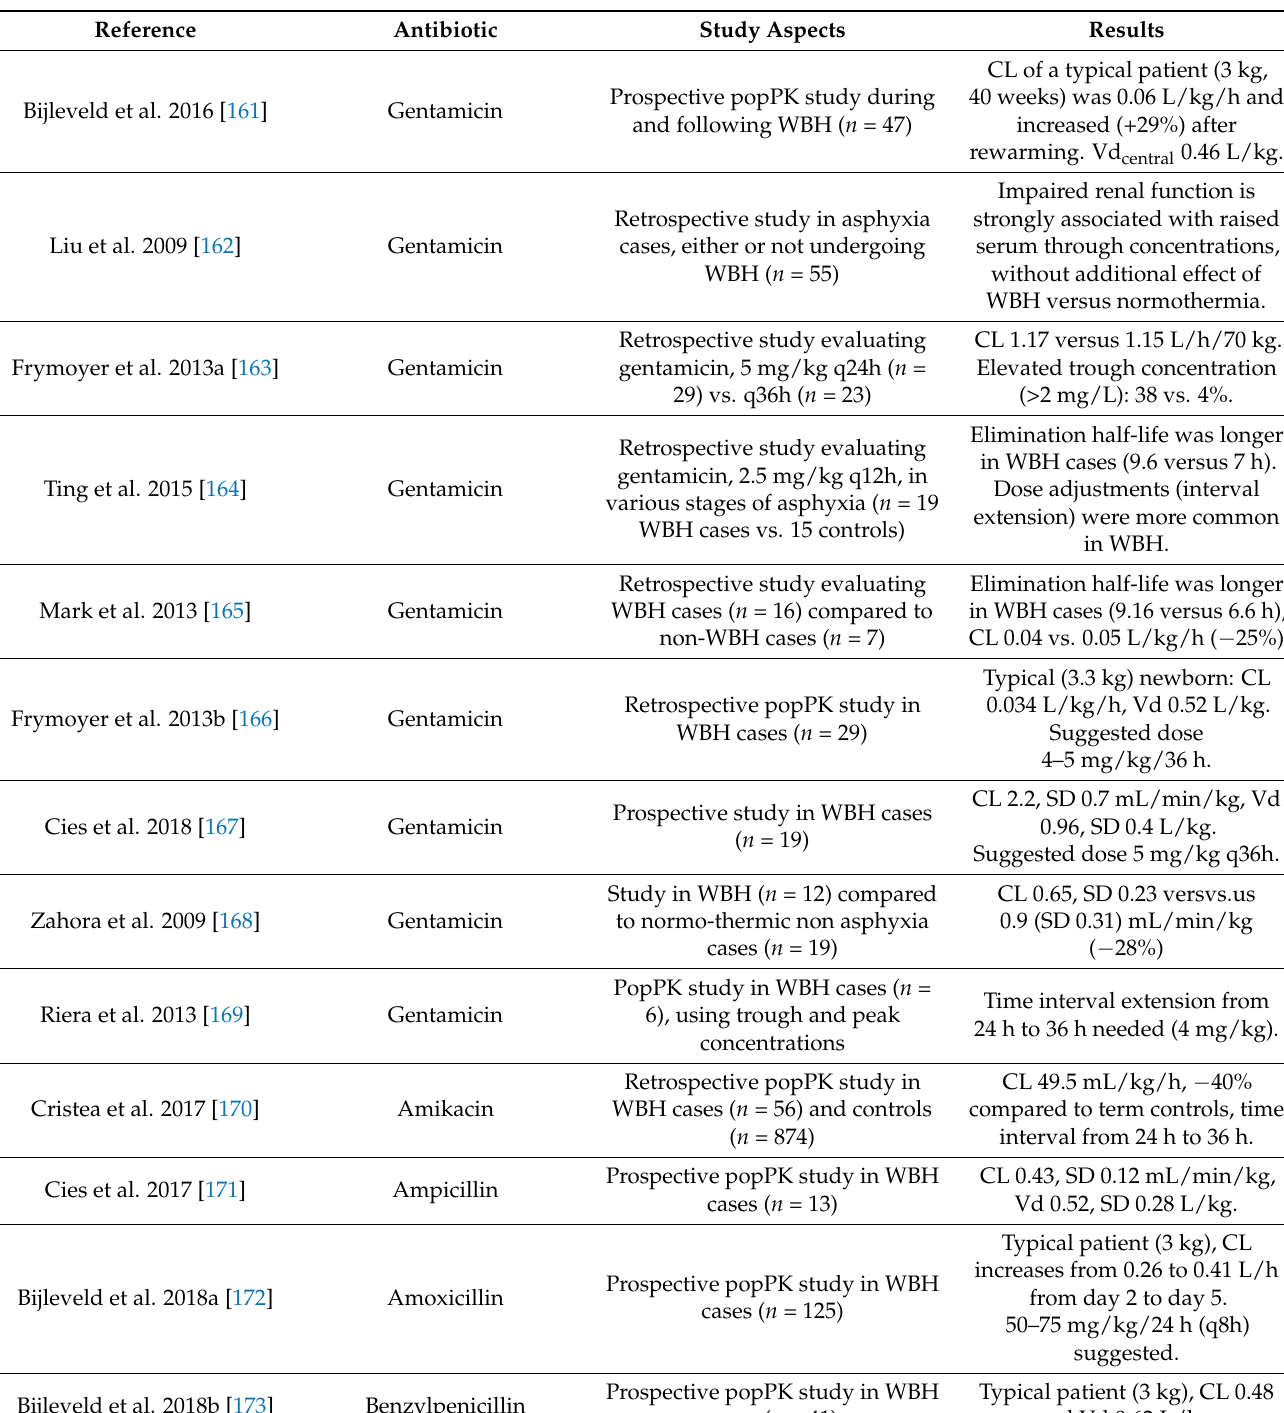
Table 8. Overview of all antibiotic PK studies performed in (near)term neonates supported with whole body hypothermia to treat moderate to severe perinatal